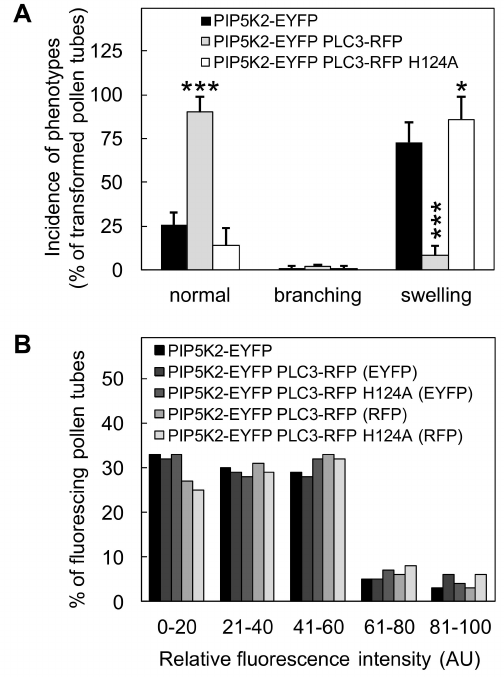
Figure 4. NtPLC3-RFP counteracts PIP5K2-EYFP-induced PtdIns(4,5)P 2 -dependent tip